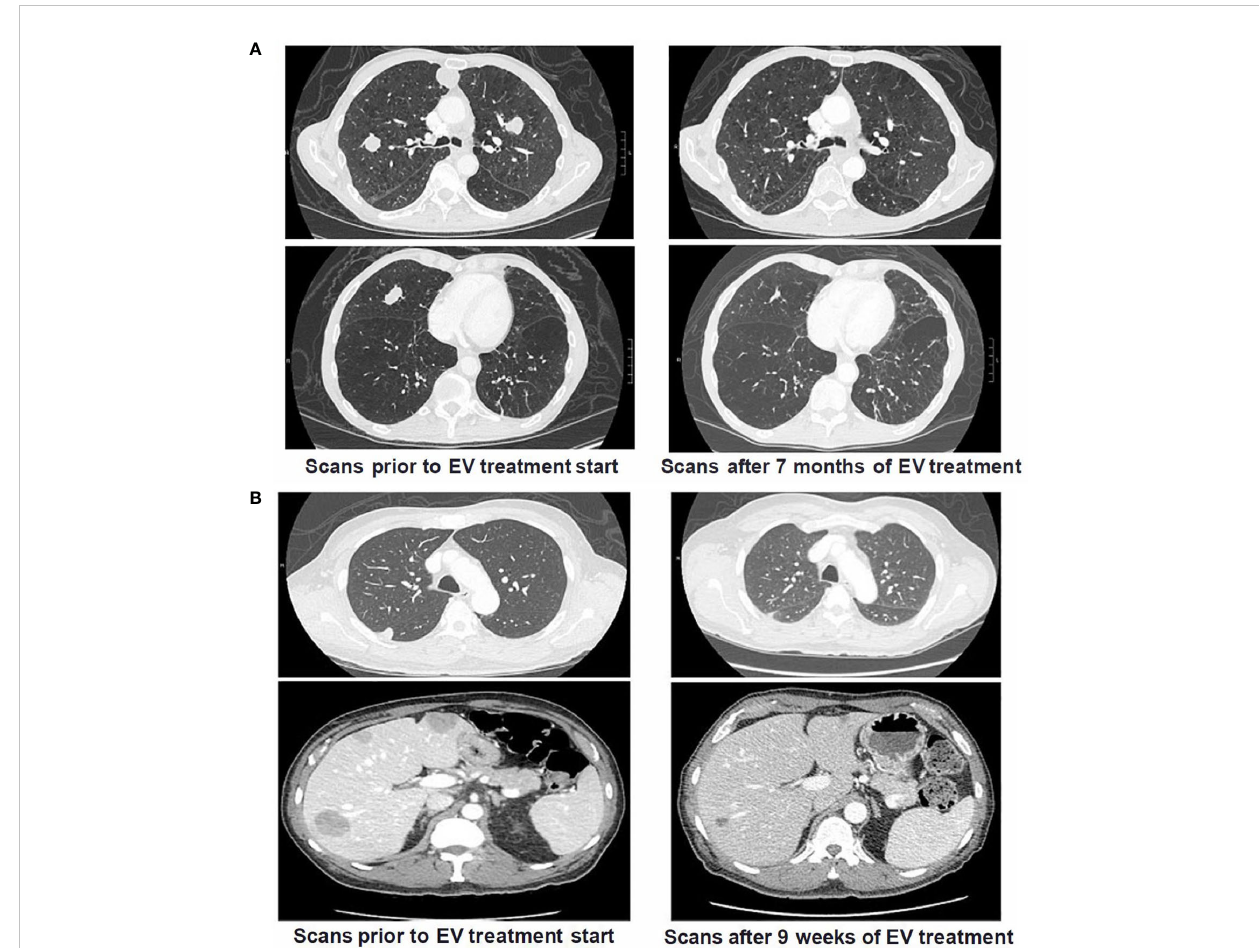
FIGURE 2 Cross Sectional Imaging of Patients with TP53 and MDM2 Somatic Alterations Pre and Post Treatment with Enfortumab Vedotin. (A) Patient with metastatic UC and TP53 alterations (p.E285* and p.E271Q) who had prior progression on both platinum-based chemotherapy and pembrolizumab. Patient had signi fi cant decrease in size of biopsy-con fi rmed pulmonary metastases after starting treatment with EV and eventually achieved a complete response. Patient continues to have radiographic CR on scans 30 months after EV treatment start. (B) Patient with metastatic UC and MDM2 alteration (ampli fi cation) who had prior progression on a clinical trial of an immune checkpoint inhibitor combination regimen with metastases in lungs and liver. Following start of EV treatment, patient had marked reduction of metastatic burden after only 9 weeks and continued on treatment for >18